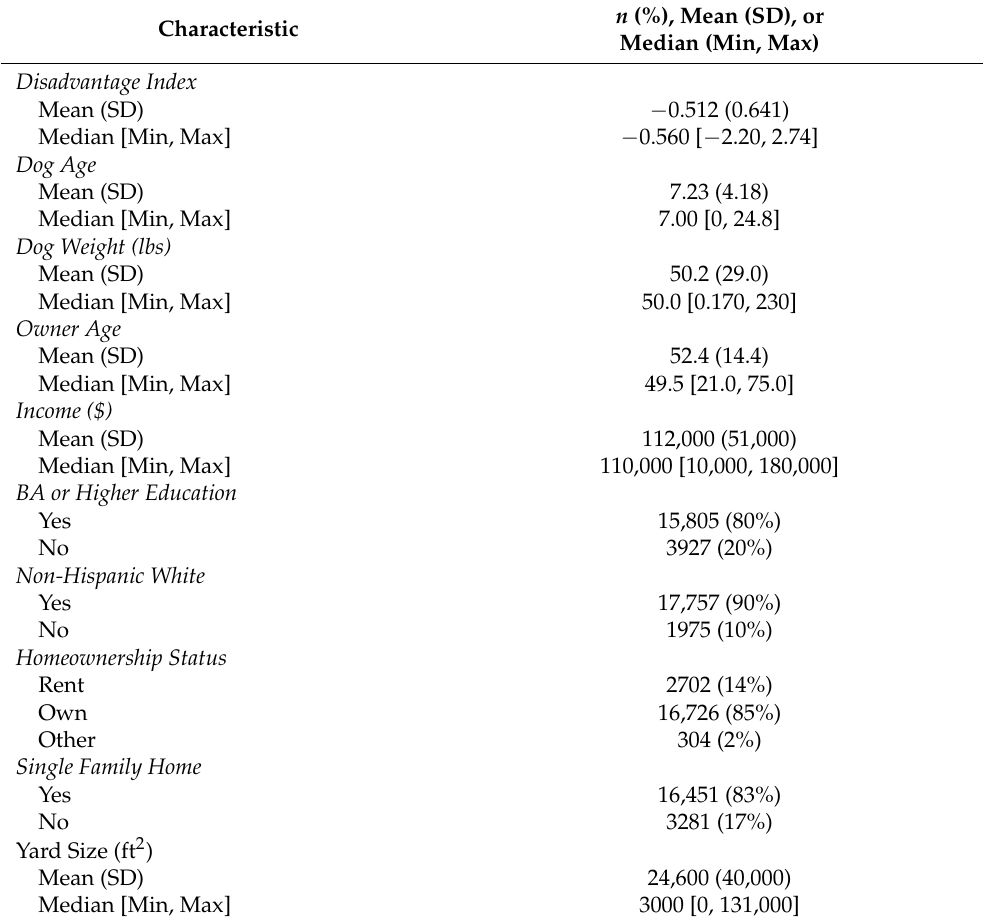
Table 2. Descriptive Statistics of Neighborhood Disadvantage Index and Control